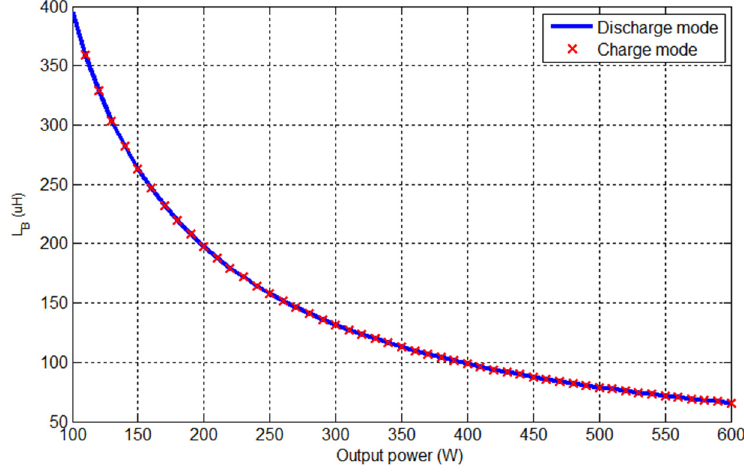
Figure 12. Boundary inductances in various power